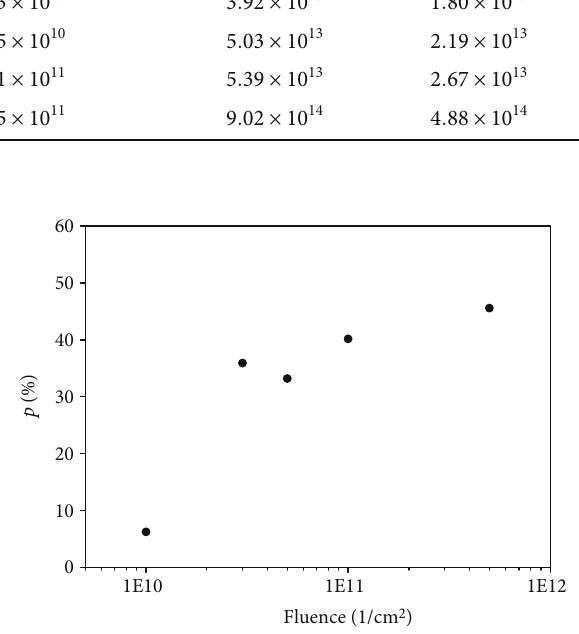
Figure 9: p increases with irradiation fl uence